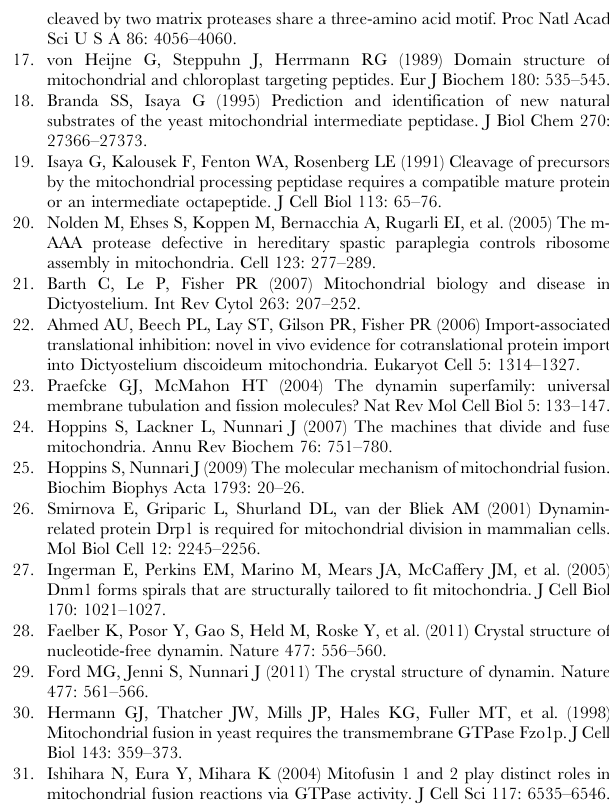
(TIF) Figure S2 Mitochondrial localization of dynamin B presequence mutant constructs. (A) Cells transformed with NTS D I2, (B) NTS D I2 K2A, (C) NTS D I2 K38A-K40A, (D) NTS D RS and (E) NTS R105A are shown. Cells were co-stained with mitoporin. Scale bars, 5 m m. (TIF) Figure S3 The dynamin B presequence targets EGFP to mitochondria in mammalian cells. (A) HEK293T cells transfected with pEGFP (control), (B) pEGFP – NTS, (C) pEGFP – NTS D RS and (D) pEGFP – NTS R105A are shown. Cells were live-stained with Mitotracker Alexa 633 and subsequently fixed. Scale bars, 10 m m. (E) Immuno-blot loaded with whole cell lysate from untransfected HEK293T cells and HEK293T cells pro- ducing EGFP and EGFP-tagged constructs NTS, NTS D RS, and NTS R105A. Constructs NTS, NTS D RS, and NTS R105A are completely processed. (TIF) Figure S4 Importance of R-like recognition sequence in mitochondrial targeting and processing in mammalian cells. Deletion of the R-like recognition site or mutation of R105A in the context of the D I2 construct leads to a significant decrease in mitochondrial targeting. (A) HEK293T cells trans- fected with pEGFP – NTS D I2, (B) pEGFP – NTS D I2– D RS, and (C) pEGFP – NTS D I2–R105A are shown. Cells were live-stained with Mitotracker Alexa 633 and subsequently fixed. Scale bars, 10 m m. (D) Immuno-blot loaded with HEK293T whole cell lysates from untransfected cells, cells producing EGFP, and cells producing EGFP-tagged constructs NTS D I2, NTS D I2– D RS, and NTS D I2–R105A. The upper band corresponds to the